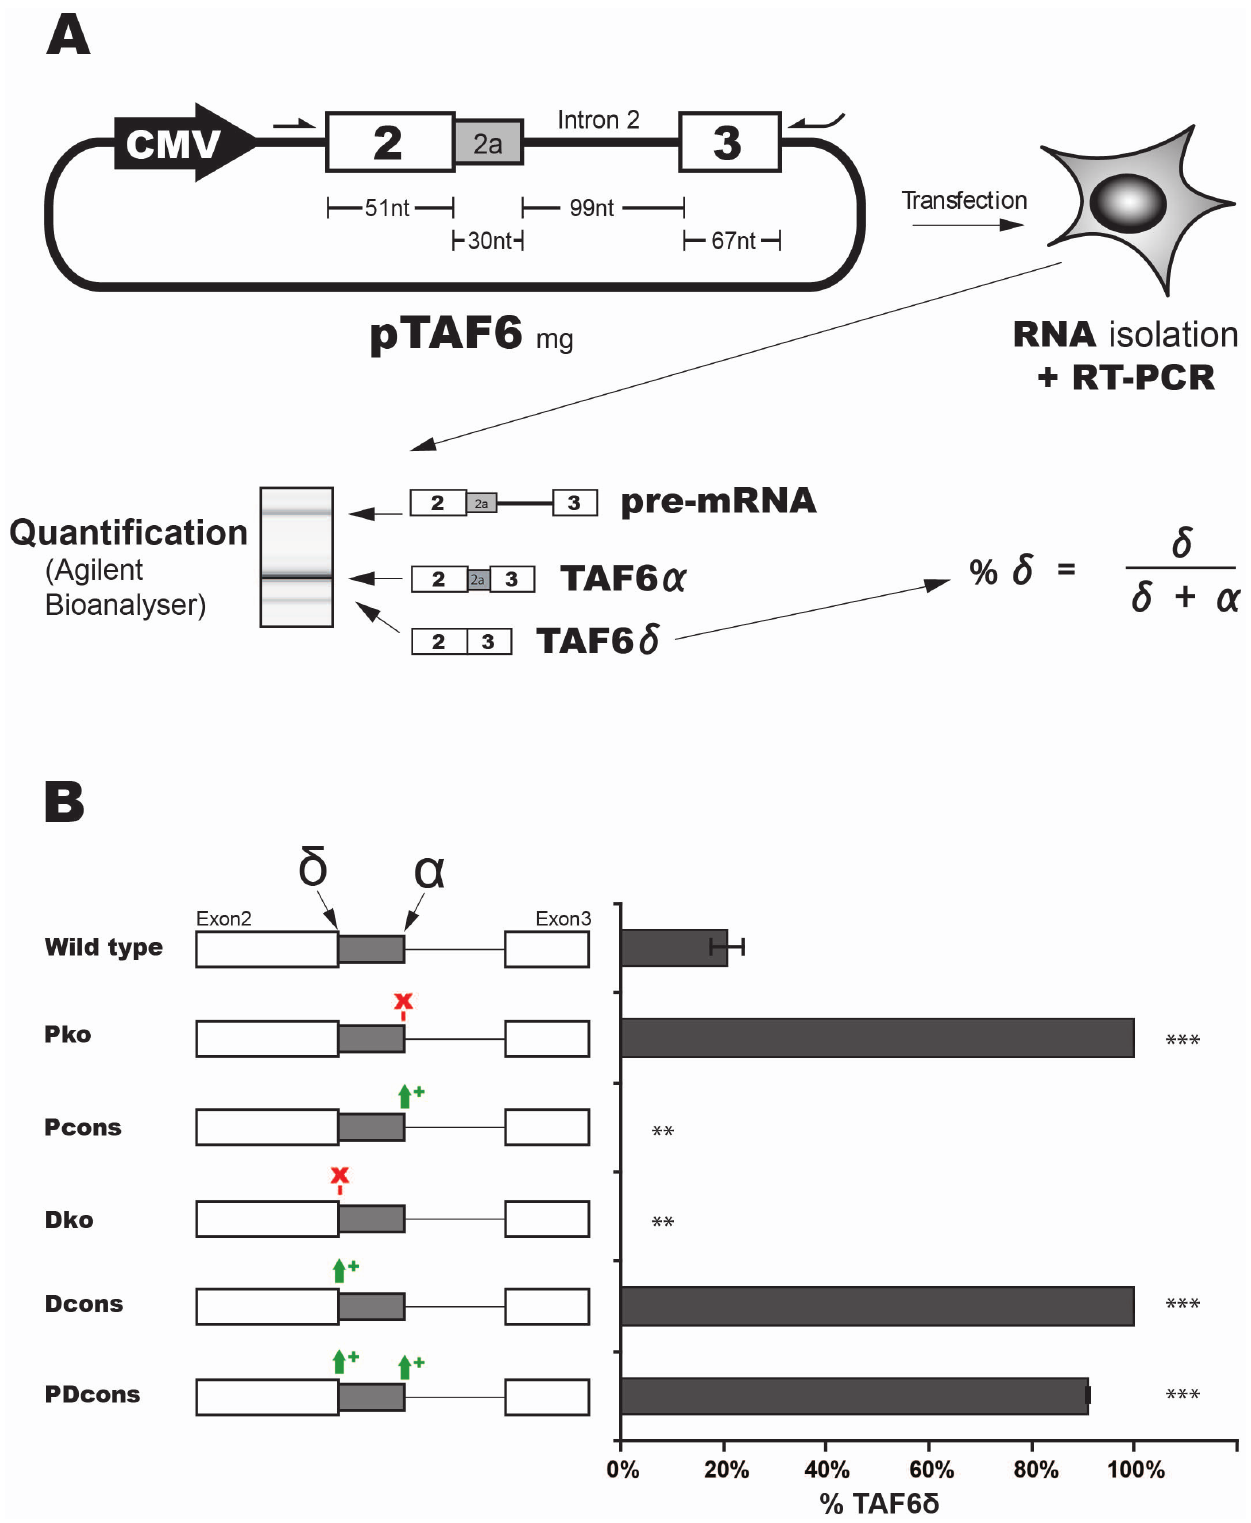
Figure 3. Development and validation of a minigene system to study the alternative splicing of TAF6. (A) A schematic diagram showing the workflow used to study cis -acting RNA sequences in TAF6 alternative splicing using a TAF6 minigene plasmid. The plasmid containing an uninterrupted genomic sequence from the taf6 gene that includes portions of exons 2 and 3, as well as the natural intron 2 is depicted alone with the positions of primers used to detect exogenously expressed RNA species by RT-PCR. Minigenes were transfected into HeLa and 42 hours later total RNA was isolated for use in RT-PCR with primers from flanking plasmid sequences. PCR products were quantified by analysis using an Agilent Bioanalyzer. The percentage TAF6 d is expressed as a ratio of total spliced TAF6 mRNAs ( d + a ). (B) Validation of the minigene system via mutagenesis. The proximal (P) 5 9 splice site (SS) and distal (D) 5 9 SS are illustrated. Mutations that knock-out (ko) SS or strengthen by creating consensus (cons) SS and their impact on the percentage of TAF6 d produced (x-axis), are indicated. (P , 0.05=*; P , 0.01=**; P , 0.001=***). doi:10.1371/journal.pone.0102399.g003 PLOS ONE |